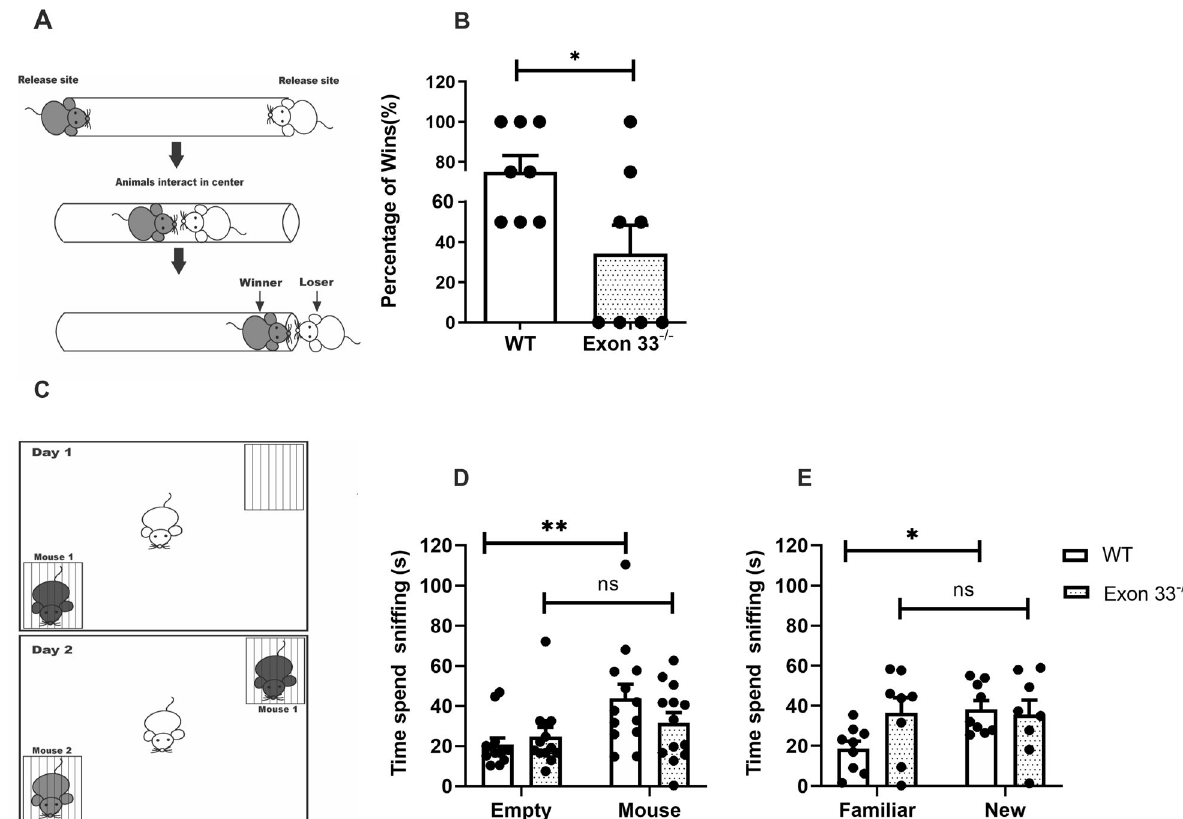
Fig. 4 Exon33 -/- mice displayed de fi cits in social dominance, sociability and social preference. A Schematic diagram of Tube Dominance Test. Two mice were placed on either side of a clear Plexiglass tube separated by removable separators. As they enter the tube from the release sites at opposite ends, they will interact at the middle of the tube. One of the mice must retreat for the other mice to continue. The dominant mice (grey) shows greater aggression and force the subordinate mice (white) to retreat. The test ends when one mouse pushed the other out of the tube. Winning was scored as binary win lose. B Exon 33 − / − mice had signi fi cantly less wins than WT when tested against WT mice. Student t -test was used for statistical analysis (WT n = 8, Exon 33 -/- n = 8, p = 0.026). C Schematic diagram of social interaction test. The subject mice (white) will be allowed to freely interact with two grid cups in the open fi eld box. On day 1, one empty grid cup and one with Mouse 1 (dark grey) was placed in the box. On day 2, one grid cup will be with the familiar Mouse 1 (dark grey), which has been introduced on day 1 and the other grid cup with a new Mouse 2 (light grey). D on day 1, WT mice spent more time snif fi ng at the grid cup with mouse, while Exon 33 − / − mice spent a similar amount of time at both grid cups. Two-way ANOVA with multiple comparisons was used for statistical analysis (WT n = 13, Exon 33 -/- n = 13, F (1, 48) = 8.064, WT p = 0.0065). E On day 2, when a new Mouse 2 was introduced in the grid cup, WT mice spent more time snif fi ng at the grid cup with Mouse 2 (new) than Mouse 1 (familiar), while Exon 33 − / − mice still spent an equal amount of time at the two grid cups. Two-way ANOVA with multiple comparisons was used for statistical analysis (WT n = 9, Exon 33 -/- n = 13, F (1, 30) = 2.757, WT p =